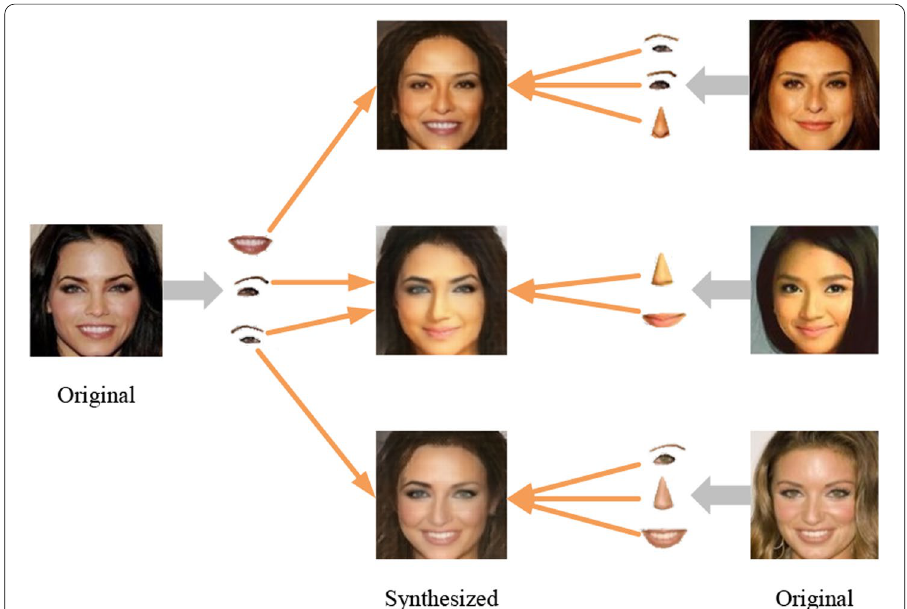
Fig. 5 Examples of synthesized images with facial parts from different persons. The original faces are shown in the left and right columns. The facial parts sent to the algorithm are indicated by arrows. The middle column shows the synthesized result images